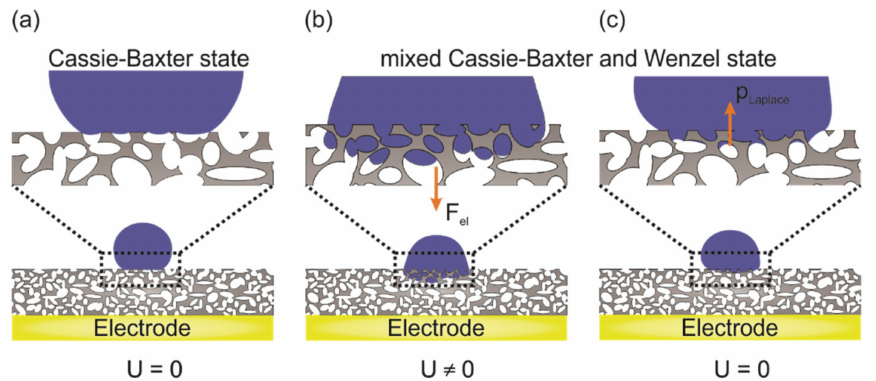
Figure 3. Schematic wetting states on a porous superhydrophobic surface, e.g., Fluoropor before, while and after application of a potential U: ( a ) In its initial wetting state the droplet sits on top of the asperities of the porous surface in the CB state. ( b ) Upon application of a potential, a downward pointing electrostatic force (F el ) evolves and drags the droplet into the pore network, causing a decrease of the CA. ( c ) When the potential is turned off again the droplet is pushed out of the pores by the Laplace pressure (p Laplace ) resulting in a decrease of the CA. However, the droplet cannot return into the initial wetting